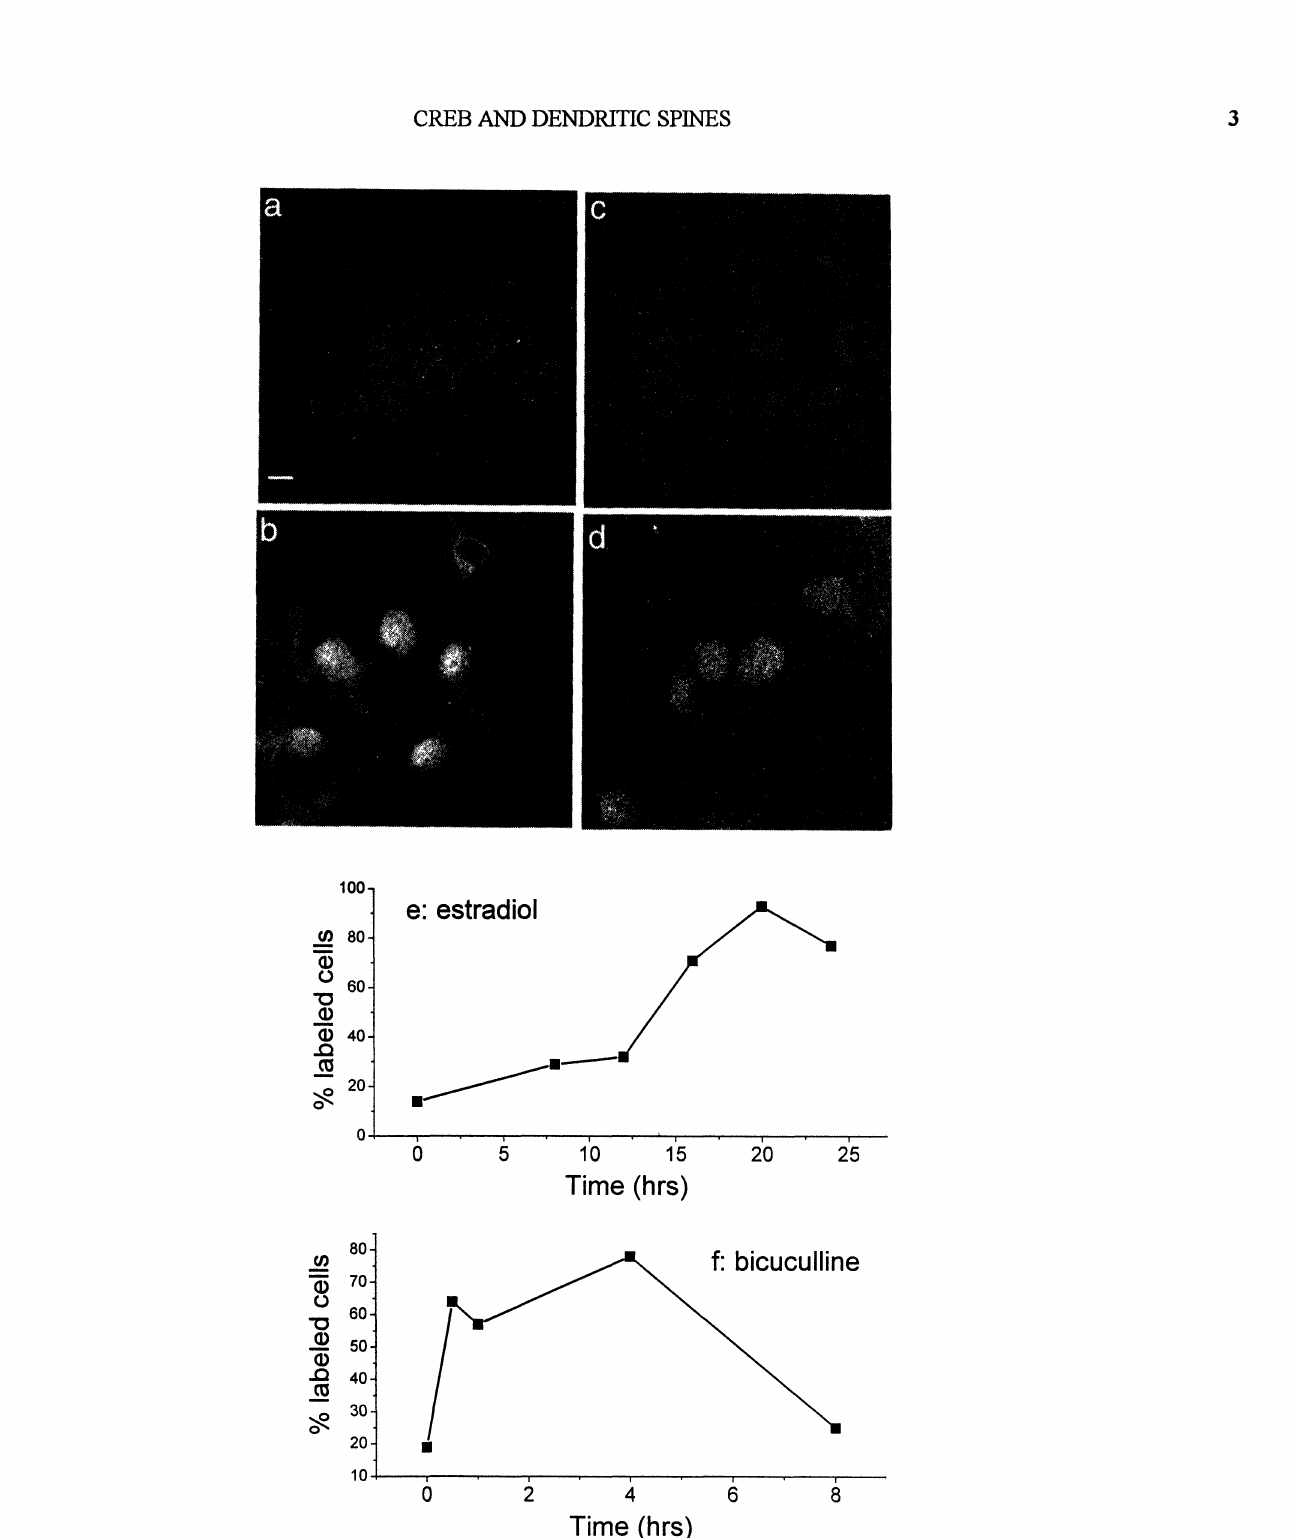
Fig. 1: A-D: Estradiol causes a rise in pCREB and CBP immunoreactivity in nuclei of cultured hippocampal neurons, in a slow time dependent manner. Illustrations of cultured neurons stained for CBP and pCREB in control and following estradiol treatment (0.1 pM, for 24hrs) A and C, are controls, B and D are estradiol-treated. A & B: CBP staining in neurons, C&D: pCREB staining in neurons (modified from Murphy & Segal, 1997). E: Time course of pCREB following exposure to estradiol. Percentage of